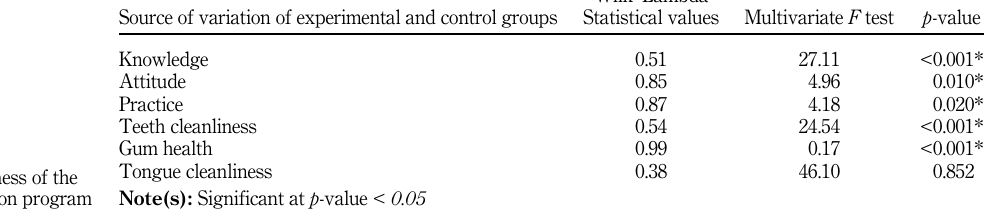
Table 3. Effectiveness of the intervention